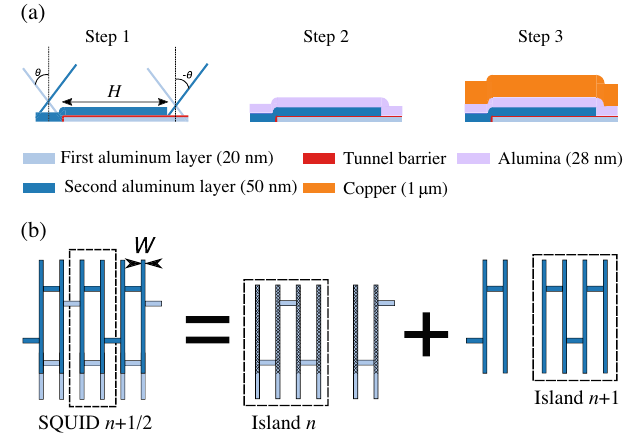
FIG. 6. Screening effect of the ground capacitance. (a) Longi- tudinal cut of a junction during the fabrication process. The first step is a double angle evaporation of aluminum via bridge-free technique with θ ¼ 35 °. The overlap between the two layers define the height H of a junction. Second step is a conformal deposition of alumina using atomic layer deposition. Third step is a sputtering of a thick copper layer. The bottom layer is mostly screened by the top layer. (b) Top view of the junctions. In this example, this short array is composed of three SQUID ’ s labeled n − 1 = 2 , n þ 1 = 2 , n þ 3 = 2 , and two superconducting islands, n and n þ 1 . Regarding the superconducting island, the capacitance between the bottom layer and the top ground is much smaller than that between the top layer and the top ground as the hatched region of the bottom layer is totally screened by the top